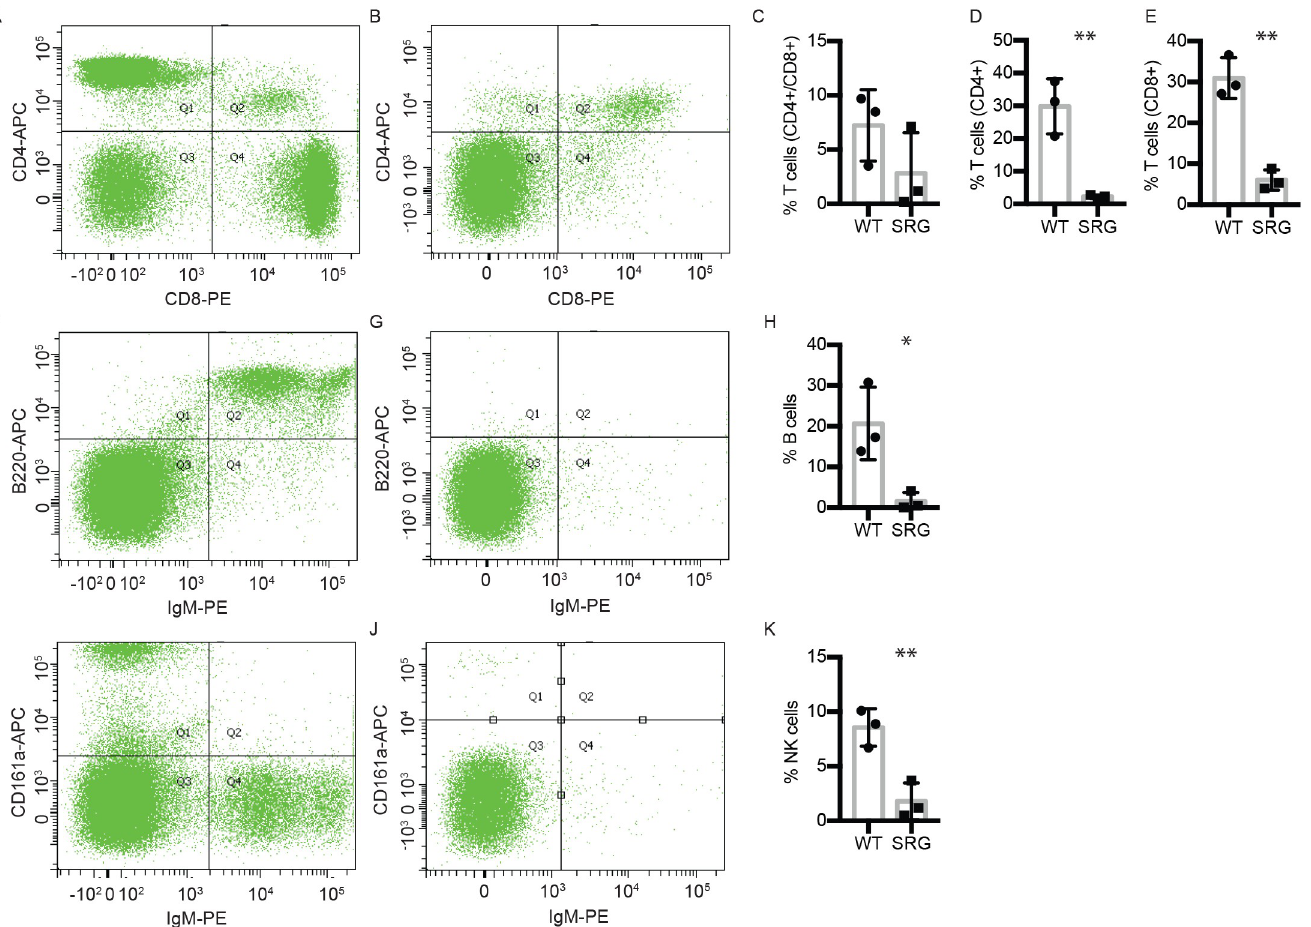
Fig 2. Immunophenotyping of peripheral blood. Flow cytometry dot plots show representative data from one WT and one SRG rat each. A-E) T cells in peripheral blood in A) wild-type rat and B) SRG rat. C-E) Quantification of data T cell populations, n = 3, error ± SD. (Unpaired t-test, p-values: �� < 0.01). T cells are significantly reduced in peripheral blood of the SRG rat (B; 1.6% CD4+, 5.3% CD8+, 1.2% CD4+/CD8+) compared to wild-type rat (A; 37.4% CD4+, 36.6% CD8+, 3.5% CD4+/CD8+). F-H) Circulating mature B cells in F) wild-type rat and G) SRG rat. The SRG rat is completely devoid of circulating mature B cells (G) compared to wild-type (F). H) Quantification of data, n = 3, error ± SD. (Unpaired t-test, p-values: � < 0.05). I-K) NK cells in the I) wild-type rat (10.1% CD161a+) and J) SRG rat (0.5% CD161a+). K) Quantification of data, n = 3, error ± SD. (Unpaired t-test, p-values: �� < 0.01). Compared to NK cells in the wild-type rat (I; 10.1% CD161a+), the SRG rat has significantly reduced circulating NK cells (J; 0.5%